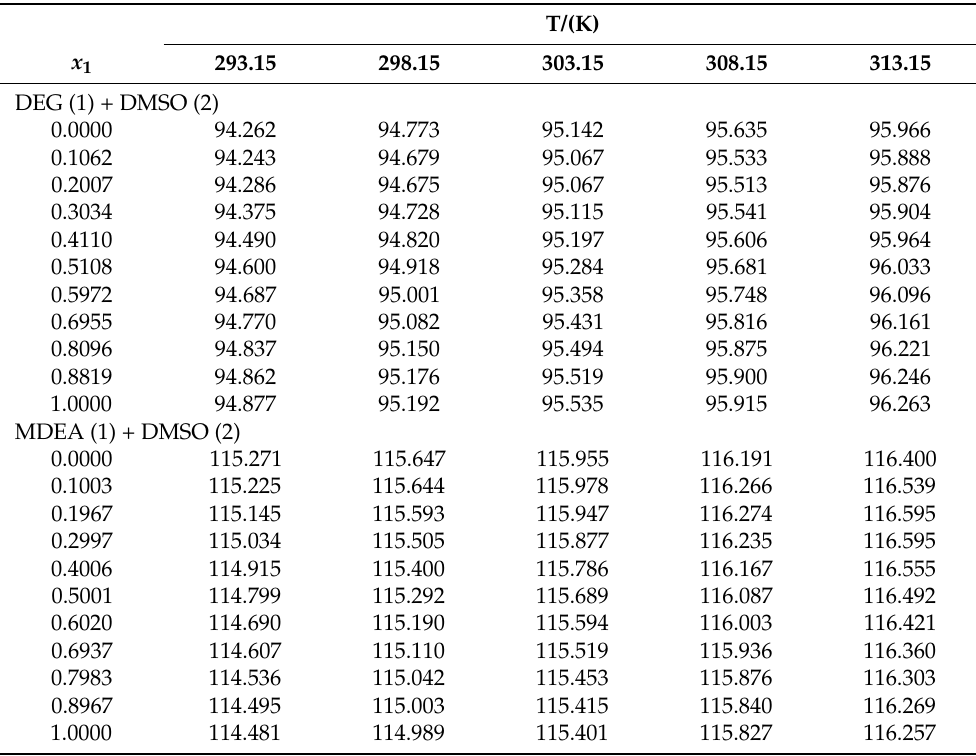
Table A7. Partial molar volumes V 1 (cm 3 · mol − 1 ) for binary systems in the temperature range from 293.15 to 313.15